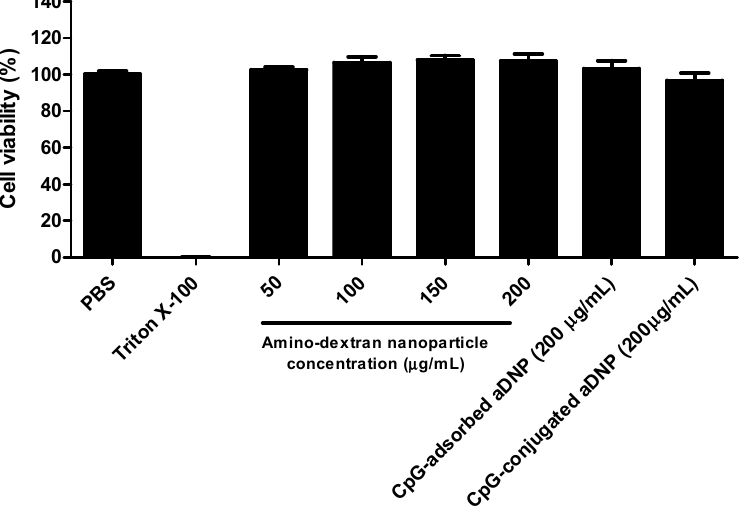
Figure 7. Cytotoxicity of unloaded aDNP and CpG-loaded aDNP on bone-marrow-derived dendritic cells after 48 h incubation. Data are presented as the mean ± S.D. ( n = 3).